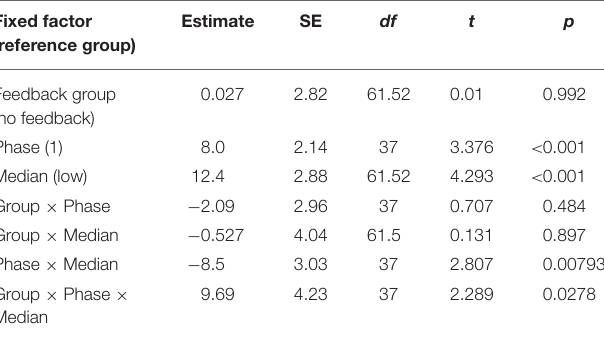
TABLE 7 | LME results after splitting data into high and low performance groups. Fixed factor (reference group)